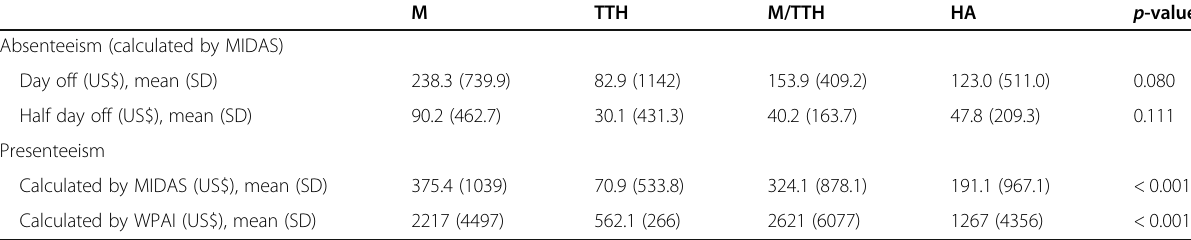
Table 4 Annual economic loss per person due to absenteeism and presenteeism M TTH M/TTH